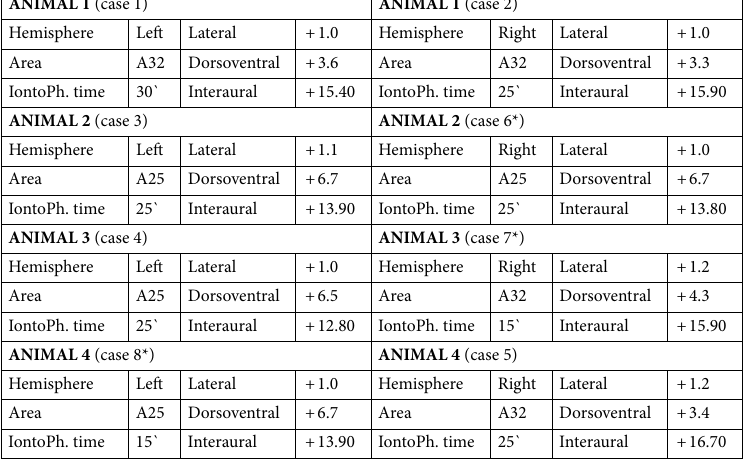
Table 2. Stereotactic coordinates of the injections performed with BDA in the common marmoset monkey cortex ( Callithrix jacchus ); based on the atlas “The marmoset brain in stereotaxic coordinates” 73 . Coordinates in millimeters (mm); IontoPh.: Iontophoresis technique; time (`) in minutes. The analysis of the injection performed in Cases 6 and 8 revealed that there was no transport of the tracer. In Case 7 the analysis revealed that the injection was integrally deposited in another area of the PFC; therefore, only five cases are presented within the